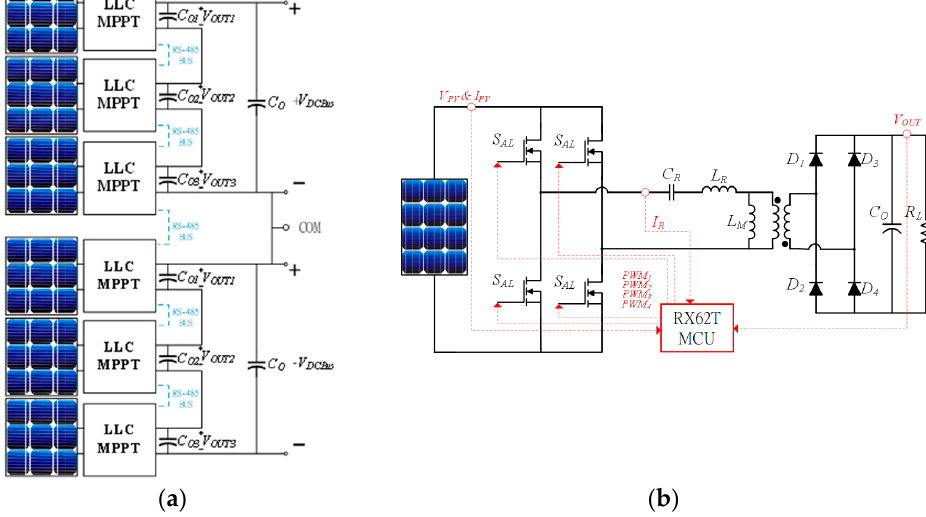
Figure 2. ( a ) A module of the LLC DC/DC converter, ( b ) the system block diagram of multi-level LLC DC/DC PV system.